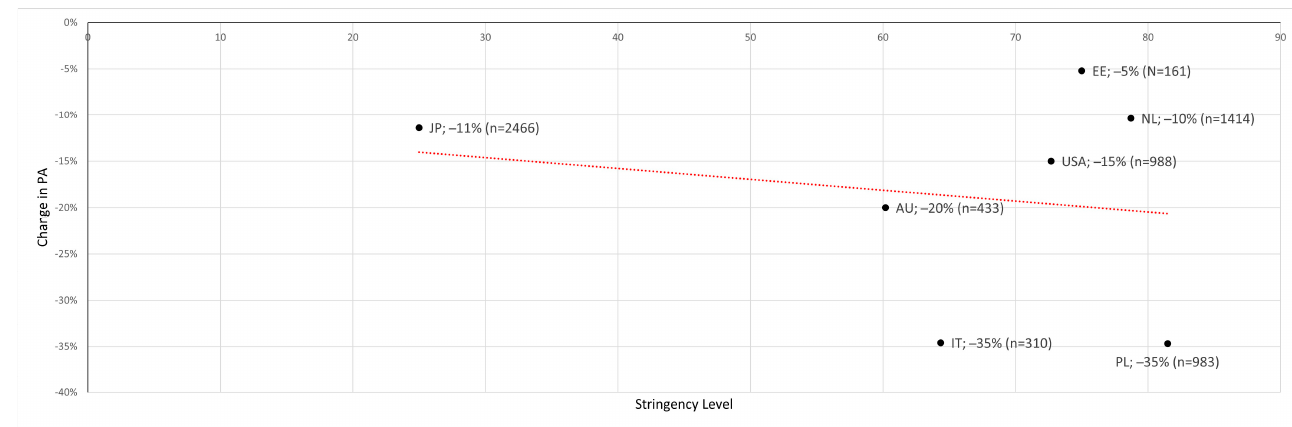
Figure 2. Change in PA to stringency level with trend line (red) [11,14,21,24,25,27,29]. Table 4. Change in PA.